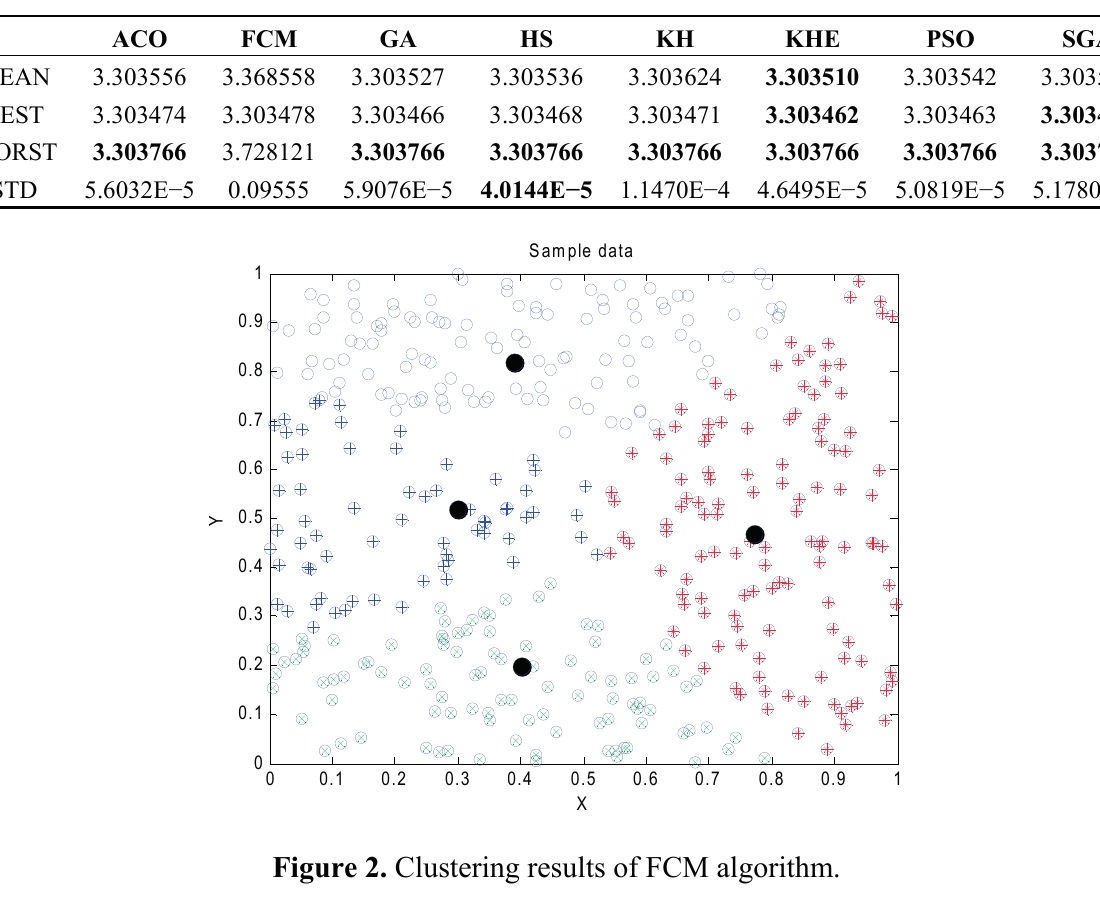
Table 3. Optimization results for the fuzzy C-means (FCM) problem.